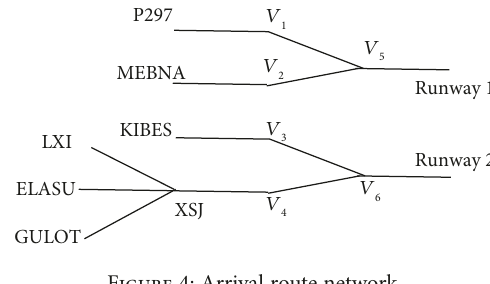
Figure 4: Arrival route network.